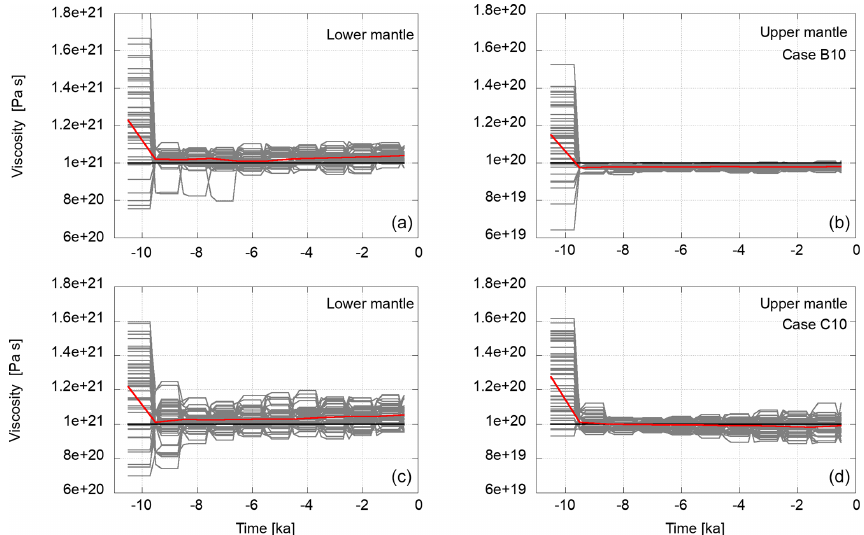
Figure 18. Variations in the viscosity in the course of the assimilation in the lower mantle (a, b) and the upper mantle (c, d) for test cases with observations starting from 10ka. Observation uncertainties are 0.25m (a, c) and 0.5m (c, d) . The flat segments represent the viscosity values of an ensemble member during the forecast phase. When observations are available, a model state may be resampled and perturbed. This changes the viscosity values as shown. The horizontal black lines represent the viscosities of the reference experiment towards which the ensemble mean is expected to converge. The red lines are the weighted ensemble means. For the initial value, all members are weighted equally. Thereafter, they are weighted by the likelihood of the observations given the current member model state.